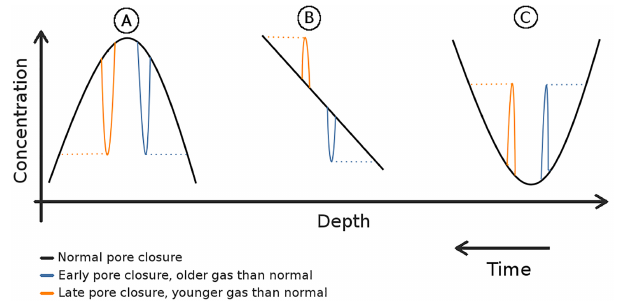
Figure 3. Expected orientation of layered trapping artifacts depend- ing on the characteristics of atmospheric variations. Black curves correspond to a normal chronological trapping, blue to early pore closure, and orange to late pore closure. Cases A, B, and C respec- tively represent local maximum, monotonous trend, and local min- imum